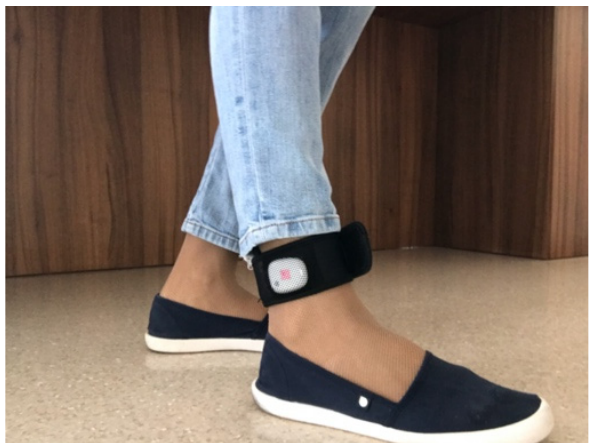
Figure 1. Dance motion capture. We use a single wearable device, including a micro-electromechanical system (MEMS) 3D accelerometer sensor, attached just above the dancer’s right leg ankle. The microposition and orientation of the sensor are arbitrary.